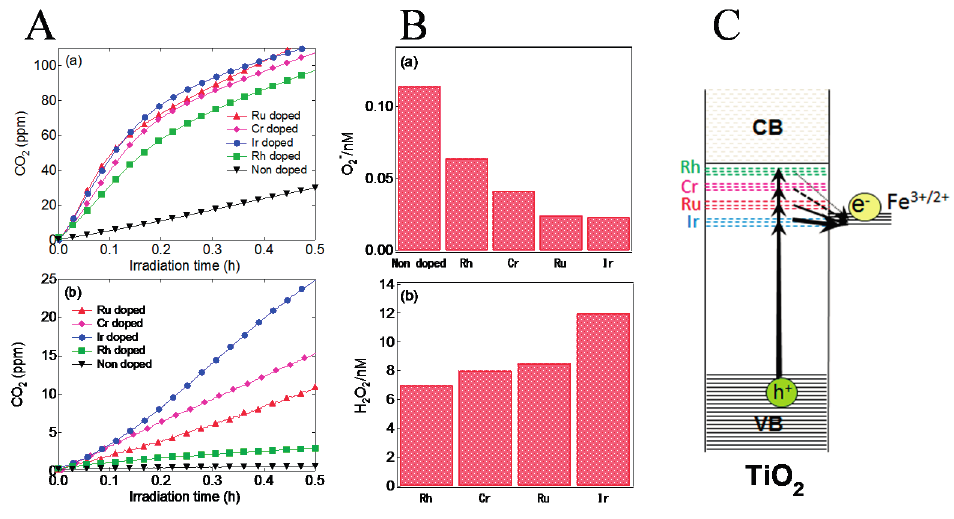
Figure 5. ( A ) Photocatalytic activities of the Fe/M:TiO 2 against gaseous acetaldehyde under visible light irradiation of ( a ) λ = 470 nm and ( b ) λ = 625 nm; ( B ) The amount of ( a ) •O 2 − and ( b ) H 2 O 2 generated on the M:TiO 2 and the Fe/M:TiO 2 , respectively under visible light irradiation of λ = 625 nm; ( C ) Schematic energy level diagram for the Fe/M:TiO 2 . Reprinted with permission from [25]. © 2014 Elsevier B.